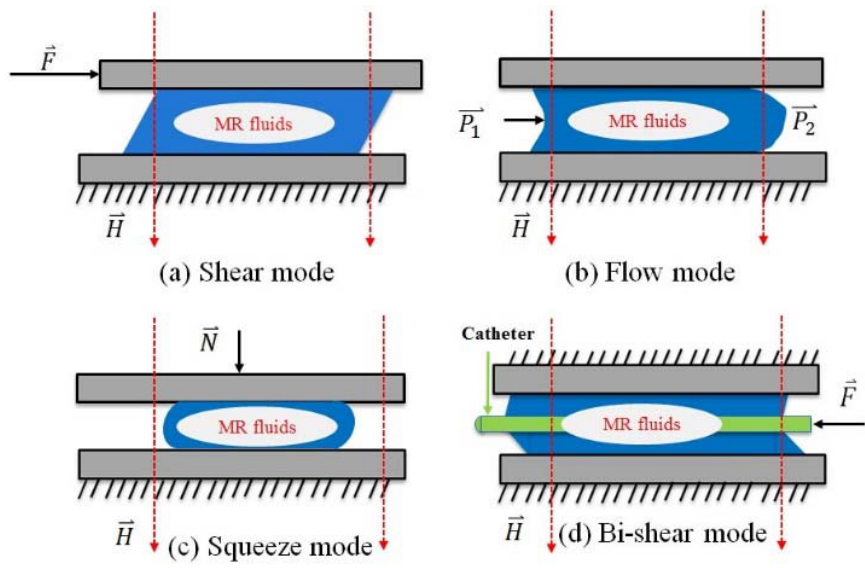
Figure 4. MR fluids working mode, in this paper, Bi-shear mode is adopted. ( a ) Share mode; ( b ) Flow mode; ( c ) Squeeze mode; ( d ) Bi-shear mode.